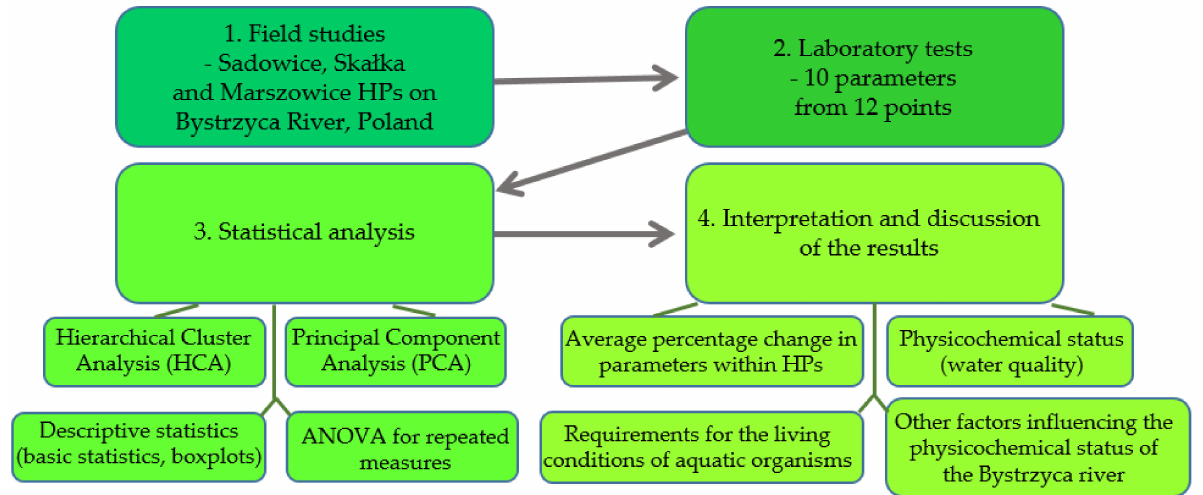
Figure 3. Research procedure followed in the